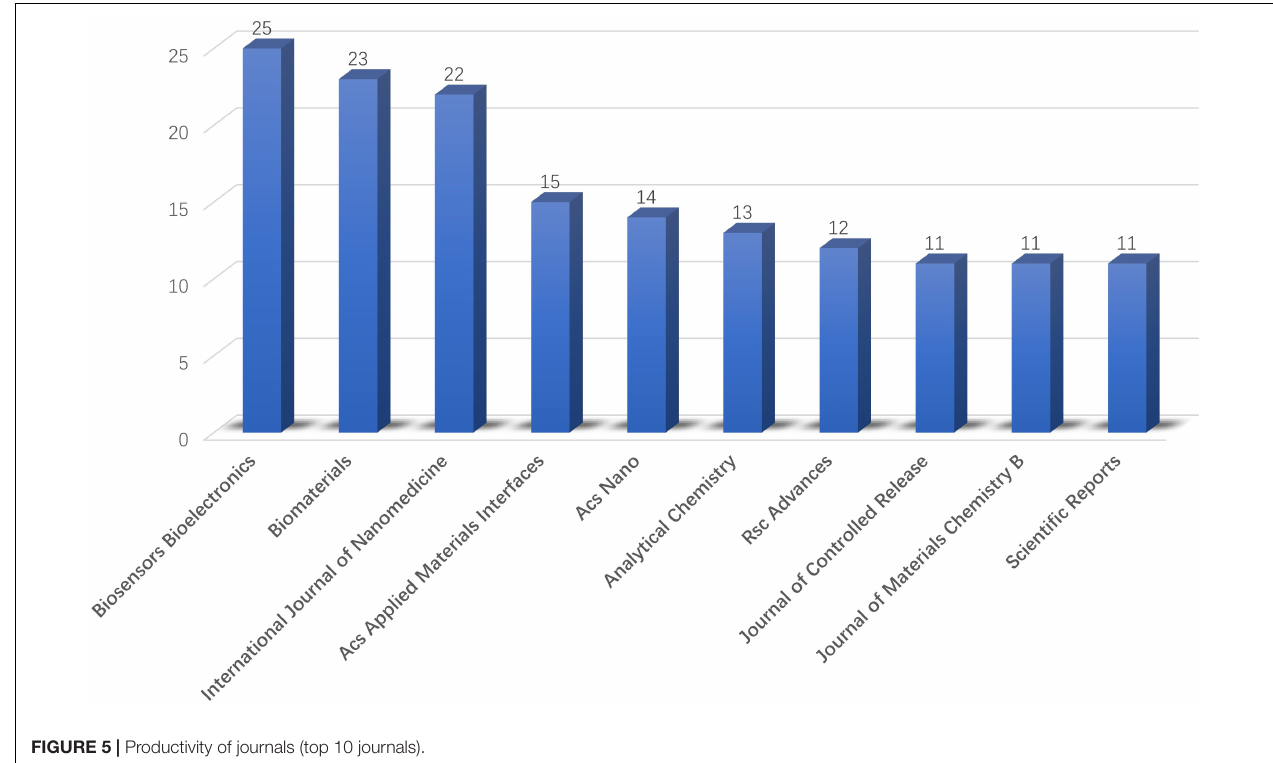
FIGURE 5 | Productivity of journals (top 10 journals).